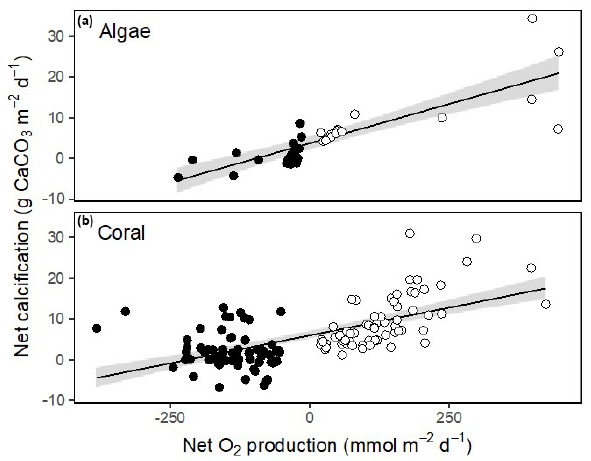
Figure 7. Relationship between net calcification rate and net pro- ductivity for calcifying algae (a) and corals (b) . Open circles indi- cate rates measured in light and closed circles show rates measured in dark. Linear fits are shown with 95% confidence intervals in grey. For calcified algae, net calcification = 3.6 + 0.039 × net O 2 produc- tion (ANOVA: F 1 , 32 = 67.0, p < 0.001). For corals, net calcifica- tion = 5.99 + 0.027 × net O 2 production (ANOVA: F 1 , 126 = 82.2, p < 0.001).